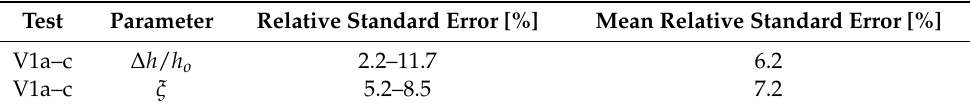
Figure 3. ( a ) Relative backwater rise ∆ h / h o versus relative solid wood volume V s , rel for tests V1a–c, ( b ) bedload transport reduction factor ξ versus V s , rel for V1a–c, and ( c ) wood trapping ratio TR = V s / V s , all for all tests. Table 2. Relative standard error and mean relative standard error of reproducibility tests